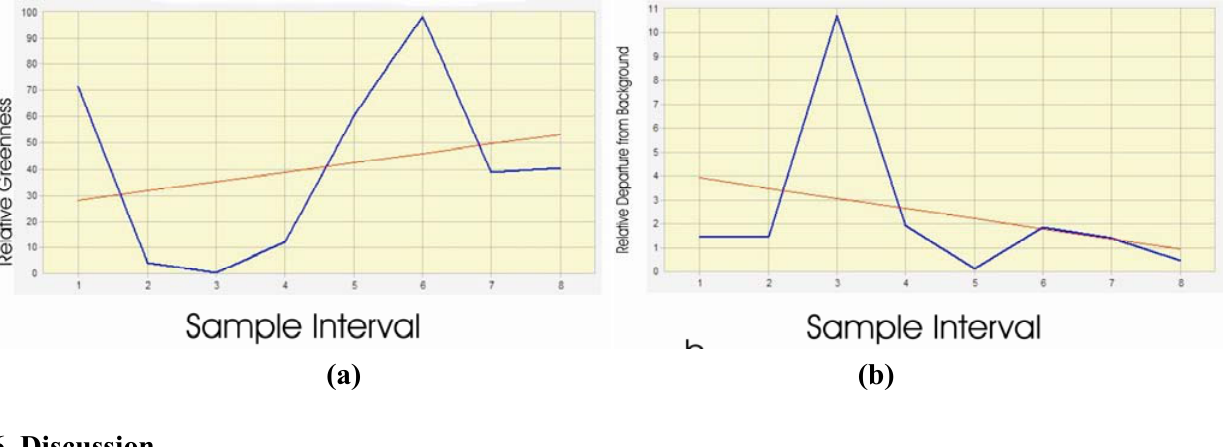
Figure 12. Greenness (a) and Anomaly (b) profiles for Sample #12 covering anniversary dates from 1998 through 2009 with x-axis not to